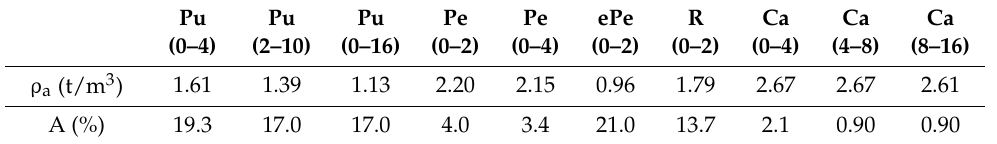
Table 2. Physical properties of